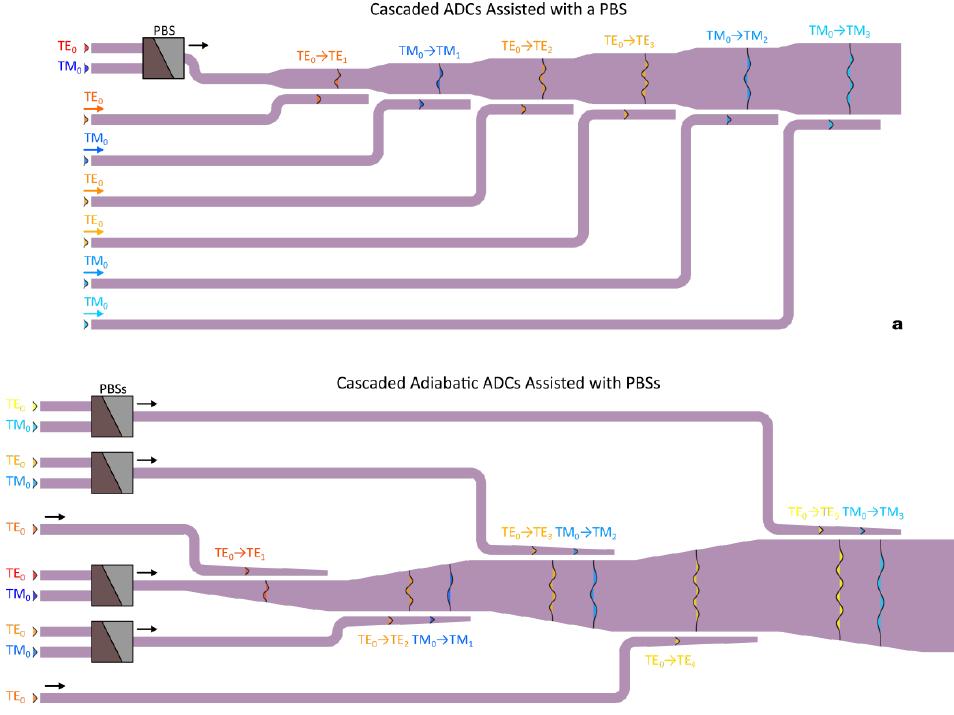
Figure 7. The schematics for the silicon polarization/mode hybrid (de)multiplexers based on ( a ) Figure7. Theschematicsforthesiliconpolarization / modehybrid(de)multiplexersbasedon( a )cascaded cascaded ADCs [96] and ( b ) cascaded adiabatic ADCs [100] . ADCs [96] and ( b ) cascaded adiabatic ADCs